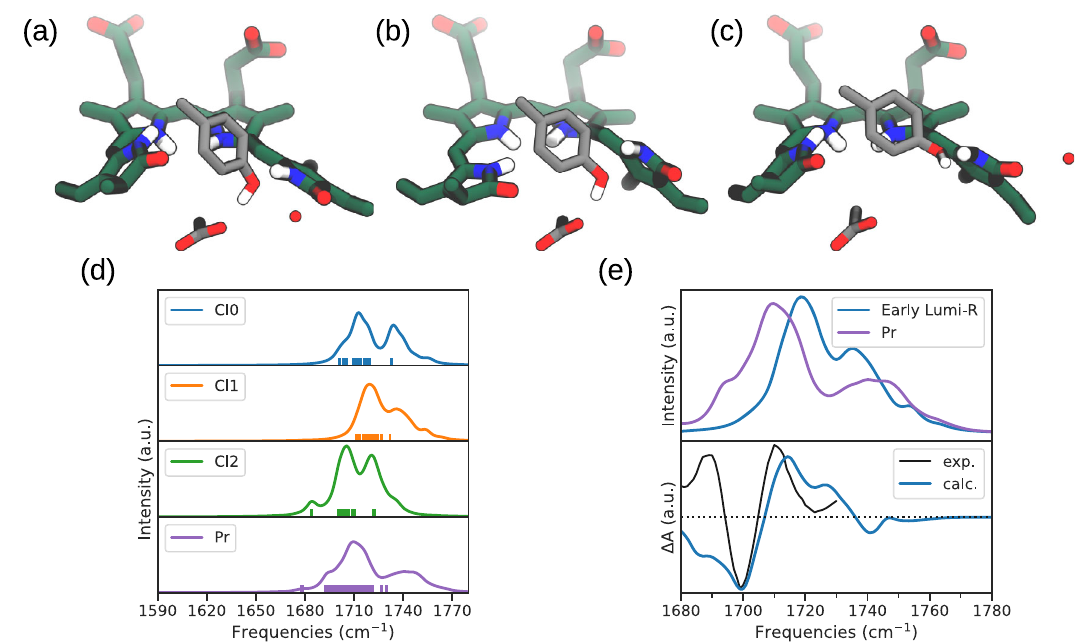
Fig. 5 | IR spectroscopy characterization. a , b , c Representative structures of cluster 0, 1, and 2, respectively. d IR spectraof the different clustersof Lumi-R and the Pr state. We have used 18, 26, and 13 con fi gurations belonging to clusters 0, 1, and 2, respectively. The sticks represent the carbonyl CO D stretch. All spectra are normalizedtothehighestpeakofCl2. e Intheupperpanel,theaveragedspectrum